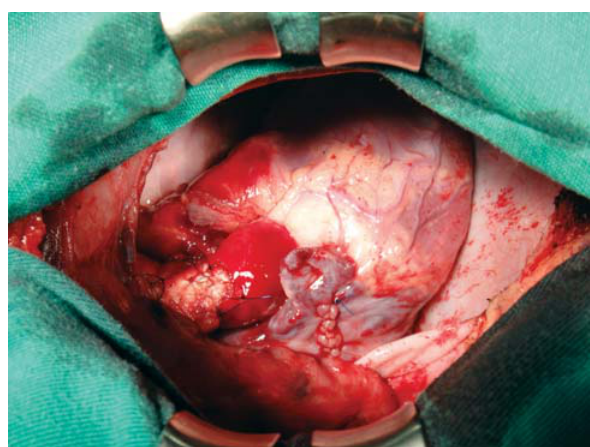
Fig.6 – Aspecto final do coração implantado momentos antes do término da operação Vídeo 2 – Aspecto final do coração implantado momentos antes do término da operação (http://www.rbccv.org.br/video/v25n2b) Controles clínicos com auxílio de exames complementares e estudo hemodinâmico com biopsia endomiocárdica não indicaram qualquer sinal de rejeição até o momento